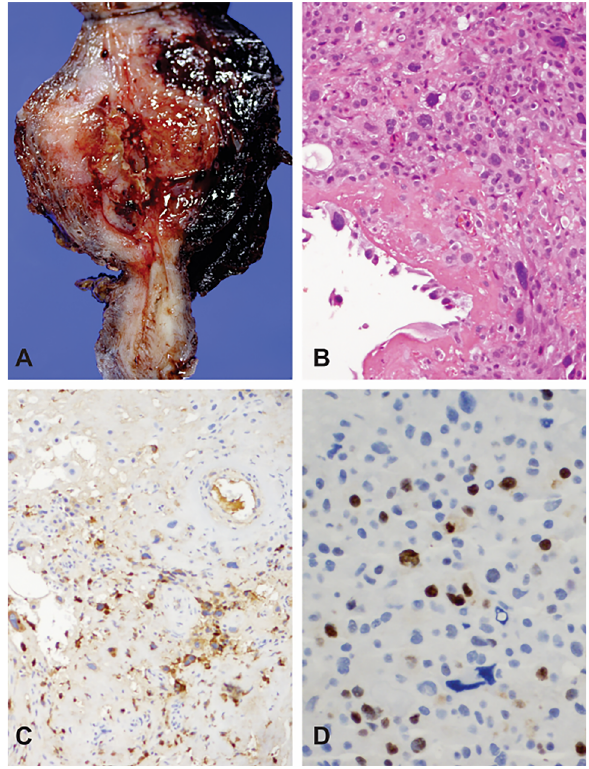
Figure 1. Macroscopy shows the serous presenting a dissecting hematoma in the fundic region on the left, extending to the isthmus. A soft white area measuring 4.5 x 3.5 cm is observed, filling the endometrial cavity, which is predominantly located in the fundic region on the left, infiltrating more than half the thickness of the myometrium (A). Immunohistological profile: hematoxylin and eosin stained uterine samples showing malignant trophoblastic cells infiltrating the decidua (B), positive immunostaining for Ki-67 in 20% of the nuclei (C) and weak staining for hCG (D) The patient was discharged 5 days later and serum hCG dropped below detectable levels within 3